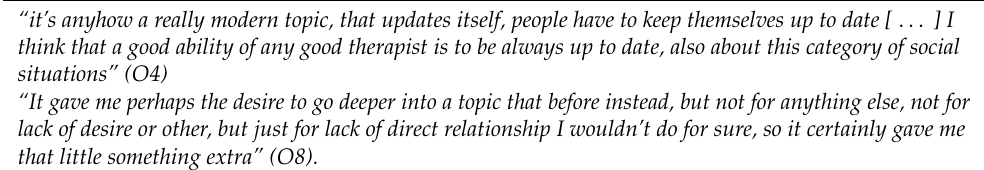
Table 13. Personal